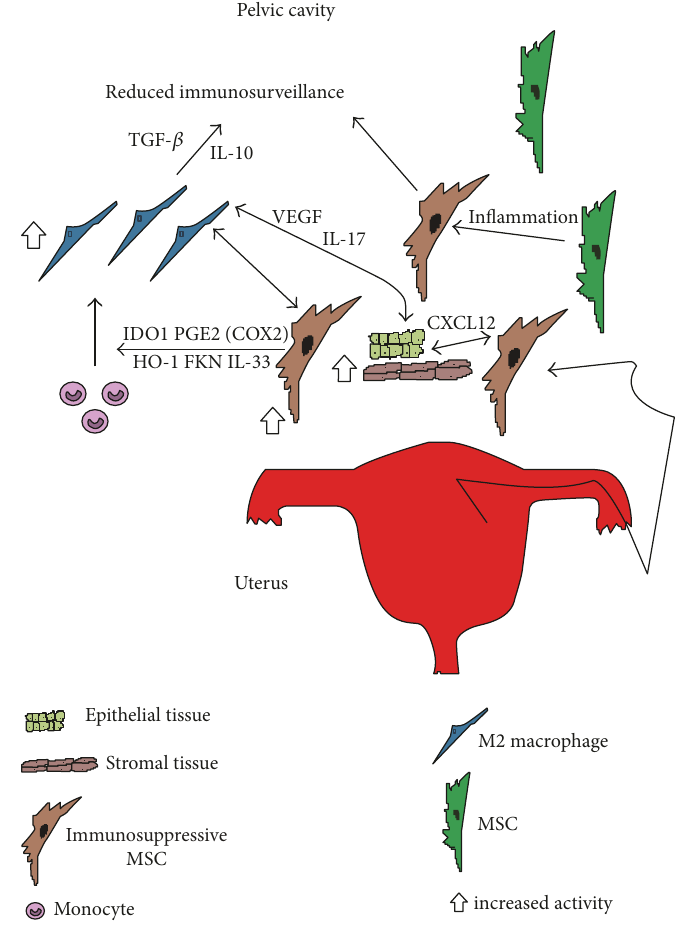
Figure 5: Schematic fi gure showing the role immunosuppressive ectopic MSC may be playing in the pathology of endometriosis. MSC along with stromal and epithelial endometrial tissue enter the pelvic cavity via retrograde menstruation. The highly in fl ammatory environment may induce MSC to become immunosuppressive to help promote tissue homeostasis. The recruited monocytes responding to the in fl ammatory environment and FKN, IL-33, IDO1, PGE2 via COX2, and HO-1 from immunosuppressive MSC may then polarize and di ff erentiate into immunosuppressive M2 macrophages. Then, M2 macrophages may increase invasion of re fl uxed endometrial cells, repair ectopic lesions, and support their growth by inducing angiogenesis via their secretion of VEGF and IL-17 [58]. In addition, secretion of IL-10 and TGF- β by the M2 macrophages may suppress other recruited immune cells to reduce immunosurveillance in the pelvic cavity [58]. Also, ectopic MSC may directly support ectopic lesion growth by promotion of tissue repair, angiogenesis, migration, invasion, and suppression of apoptosis through CXCL12. The net e ff ect may be large numbers of immunosuppressive MSC and M2 macrophages in the pelvic cavity that may directly support ectopic lesion growth, reduce immunosurveillance in the pelvic cavity, and reciprocally support each other ’ s growth contributing to the development and progression of endometriosis. MSC: mesenchymal stromal cell; FKN: fractalkine; IDO1: indoleamine 2,3-dioxygenase 1; COX2: cyclooxygenase 2; HO-1: heme oxygenase 1; CXCL12: chemokine c-x-c motif chemokine ligand 12; VEGF: vascular endothelial growth factor; IL-17: interleukin 17; IL-10: interleukin 10; TGF- β : transforming growth factor-beta; IL-33: interleukin 33; PGE2: prostaglandin